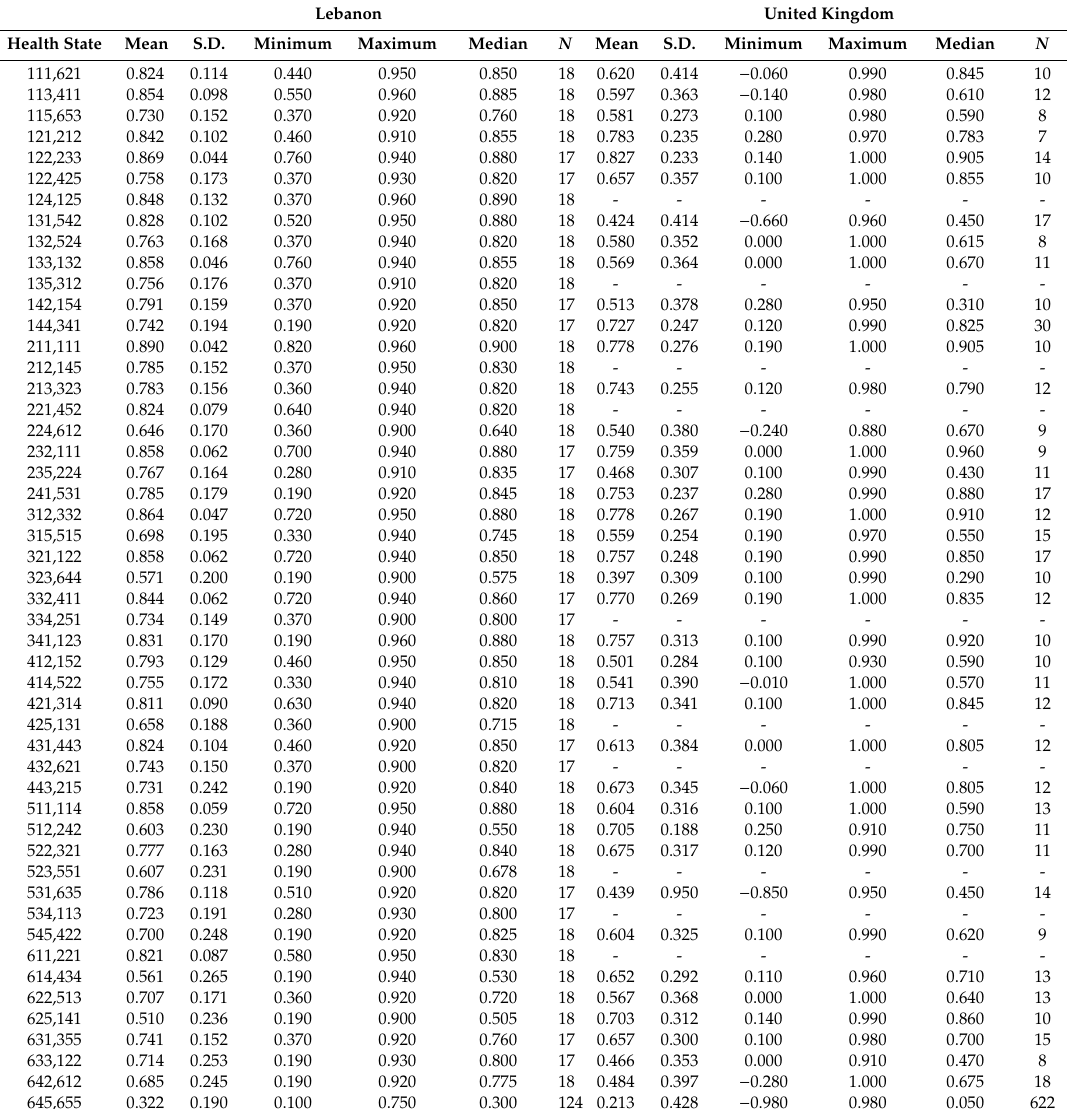
Table 3. Descriptive statistics for the 50 SF-6D health state valuations comparing Lebanon and the UK. Lebanon United Kingdom Health State Mean S.D.